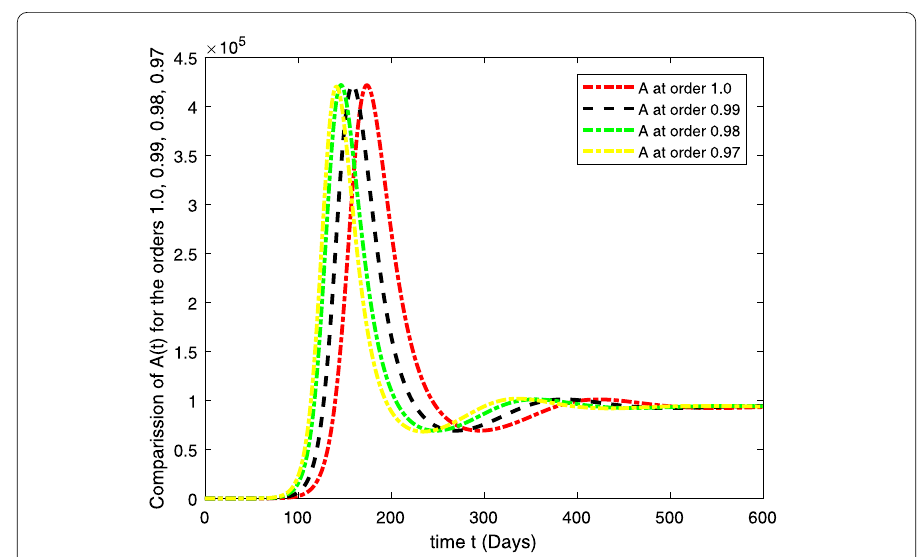
Figure 9 A comparative analysis of A ( t ) for the fractional orders 1.0, 0.99, 0.98, 0.97